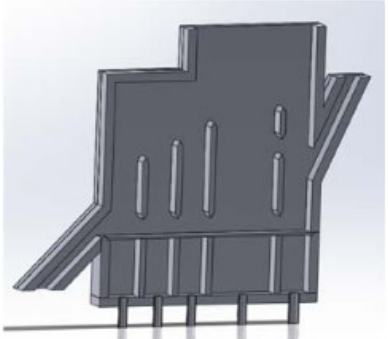
Figure 3. Classifier with internal baffles (front plate made invisible).